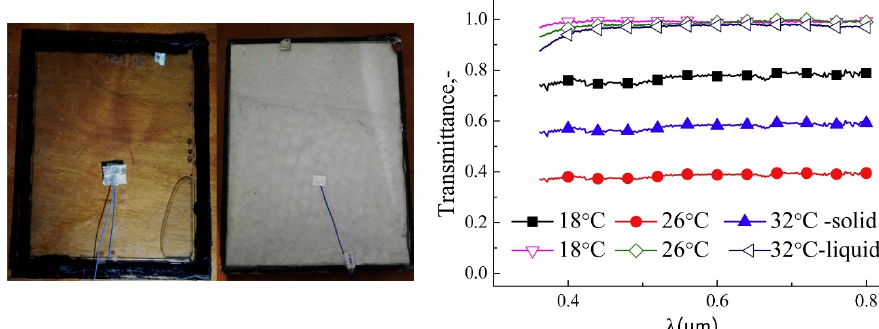
Figure 8. Paraffin wax PCM in liquid and solid phases along with their transmittance variations in different MTs [34].